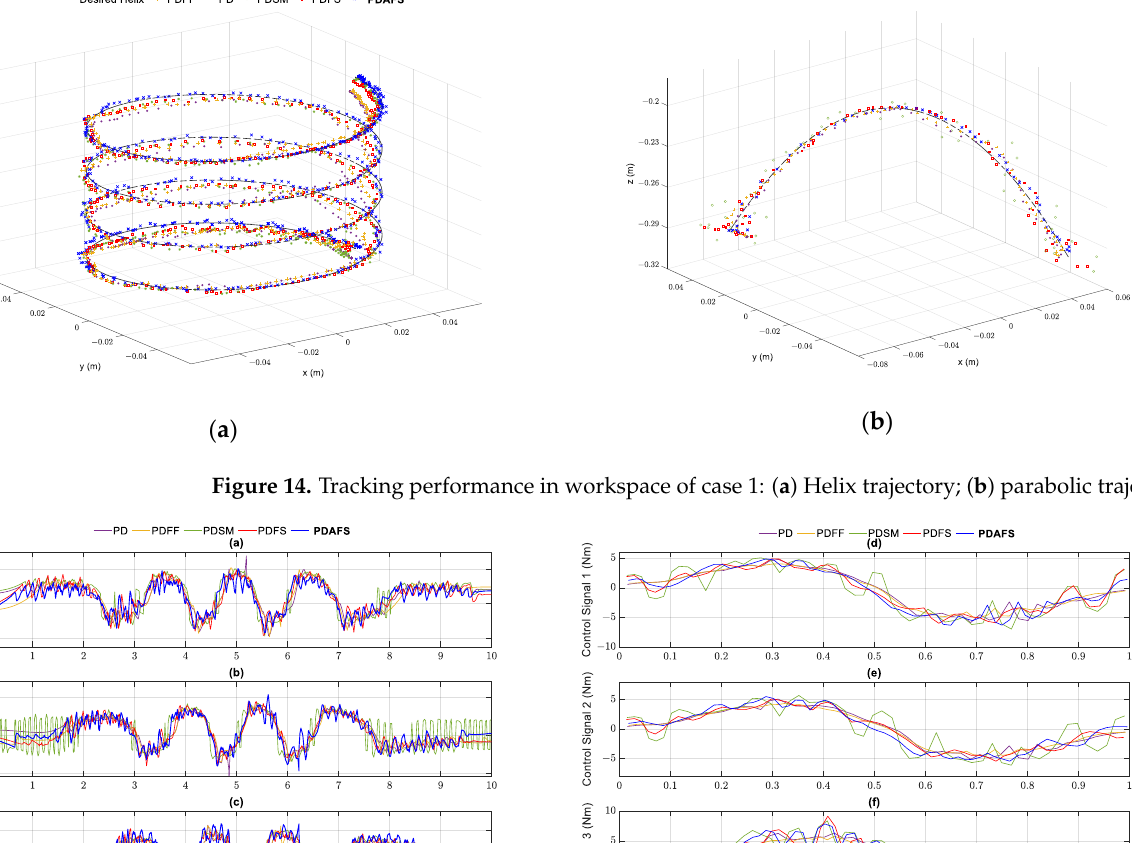
Figure 13. Parabolic trajectory performance in joint space: ( a ) joint 1; ( b ) joint 2; ( c ) joint 3 and track- ing error: ( d ) joint 1; ( e ) joint 2; ( f ) joint 3 in the experiment case 1.